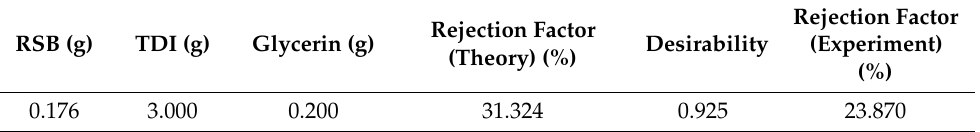
Table 5. Optimum composition solutions for polyurethane membrane synthesis.